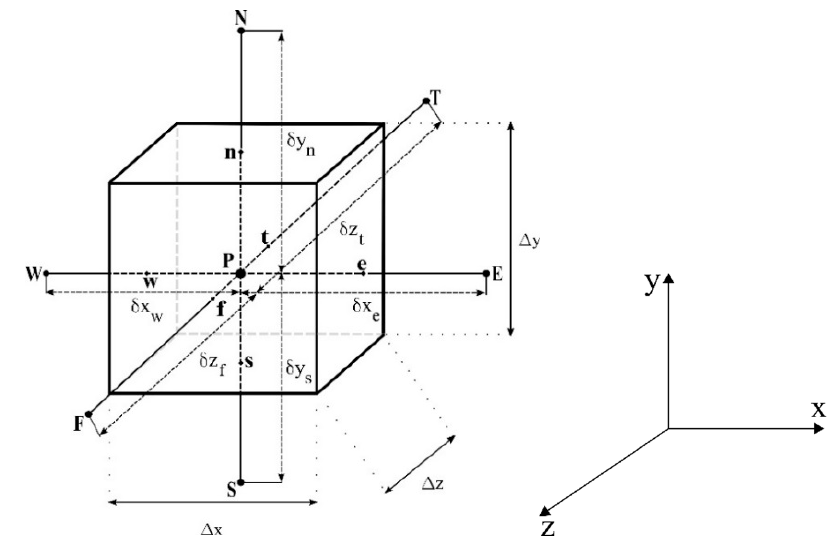
Figure 3. Control volume used for the numerical solution.